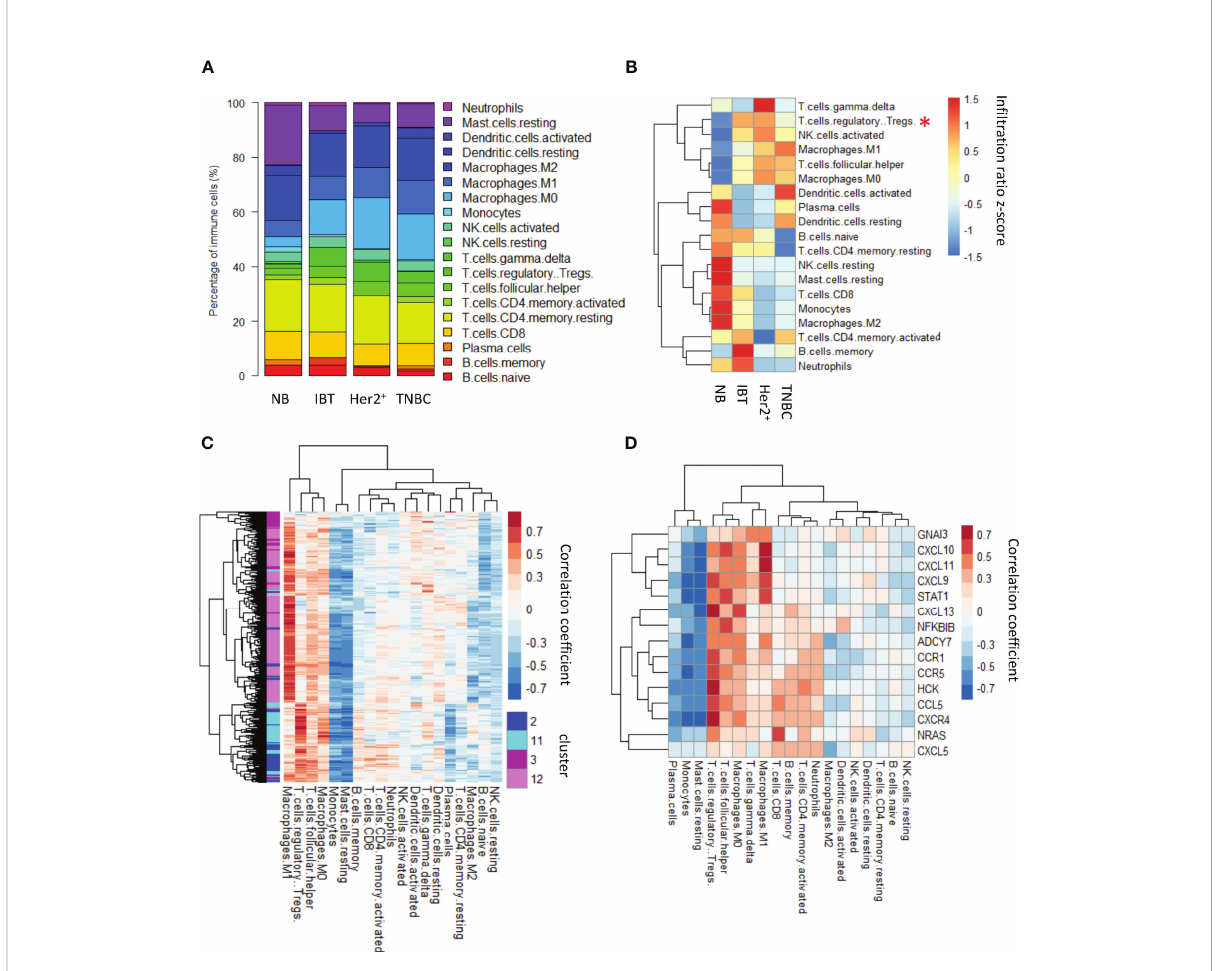
FIGURE 5 Treg cell immune in fi ltration was increased in in fl ammation and ER − breast cancer. (A) Relative contents of immune cells between normal, in fl ammation, and cancer stages. (B) A heatmap showing average content of immune changes between normal, in fl ammation, and cancer stages. “ * ” , p-value < 0.05; “ ** ” , p-value < 0.01 and “ *** ” , p-value < 0.001. (C) The correlation between interface genes and immune cell in fi ltration. (D) The correlation between chemokine signaling pathway genes in interface genes and immune cell in fi